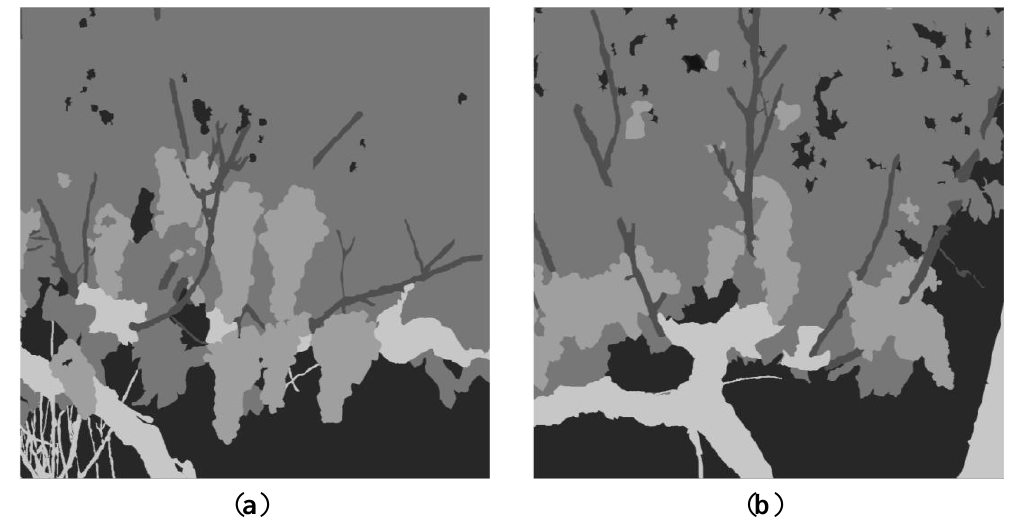
image corresponding to the scene